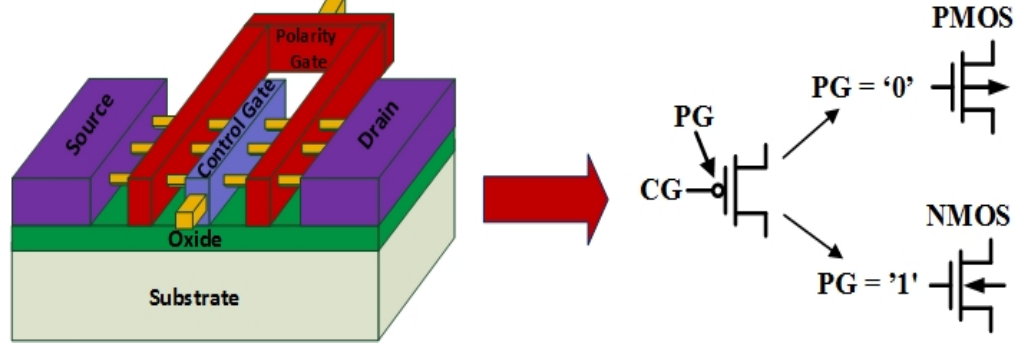
Figure 11. Schematic illustration of silicon a silicon nanowire transistor.